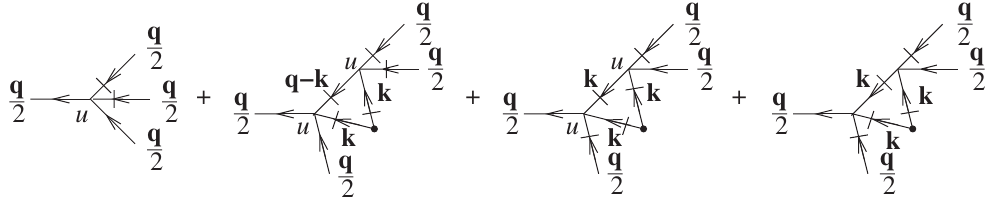
FIG. 3. One-loop renormalization of the relaxation vertex. One-particle irreducible diagrams contributing to the four-point vertex function Γ ~ ψψ (cid:2) ψ (cid:2) ψ ðf q = 2 g ; f ω = 2 gÞ